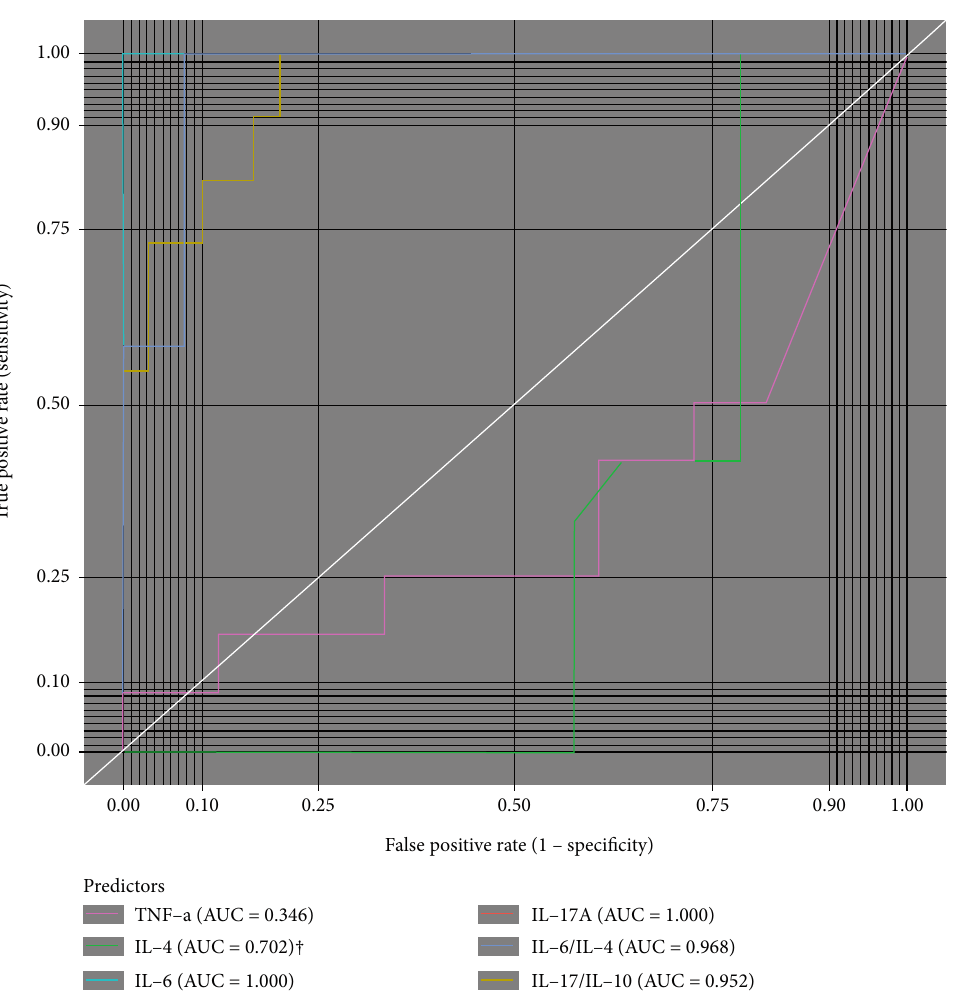
Figure 4: Performance of selected T cell cytokines to discriminate low and moderate DAS scores in RA. † Test direction is negative (smaller test results indicate presence of